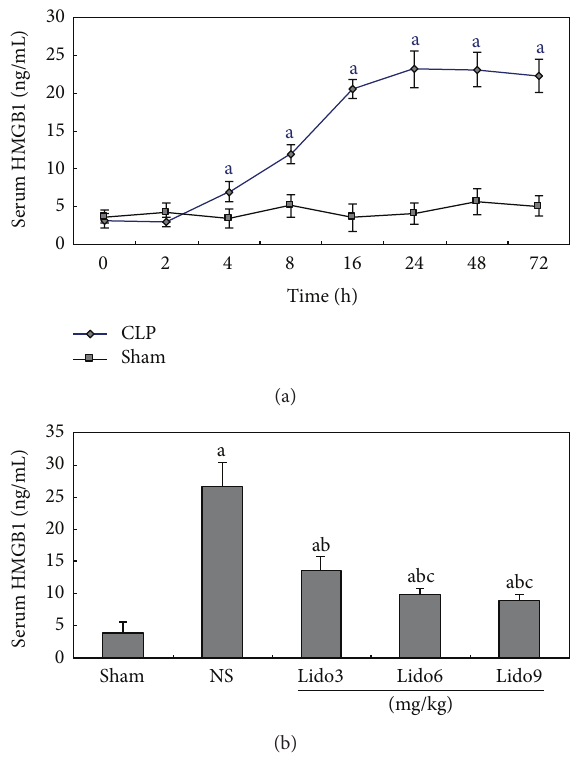
Figure3:LidocainetreatmentdecreasesofsystemicHMGB1release in CLP-induced septic rats. (a) Time course of changes in serum HMGB1 levels. Serum from rats with or without CLP was collected at various time points (0, 2, 4, 8, 16, 24, 48, and 72 h after CLP). SerumHMGB1levelsweremeasuredbyELISA.Datawerepresented as mean ± SD ( 𝑛 = 5 ). a 𝑃 < 0.05 versus Sham. (b) Serum from rats subjected to CLP treated with NS and rats subjected to CLP treated with lidocaine 3, 6, and 9mg/kg at 24 h after CLP. Serum HMGB1 levels were measured by ELISA. Data were presented as mean ± SD ( 𝑛 = 5 ). b 𝑃 < 0.05 versus NS; c 𝑃 < 0.05 versus Lido3 mg/kg. NS: normal saline; Lido: